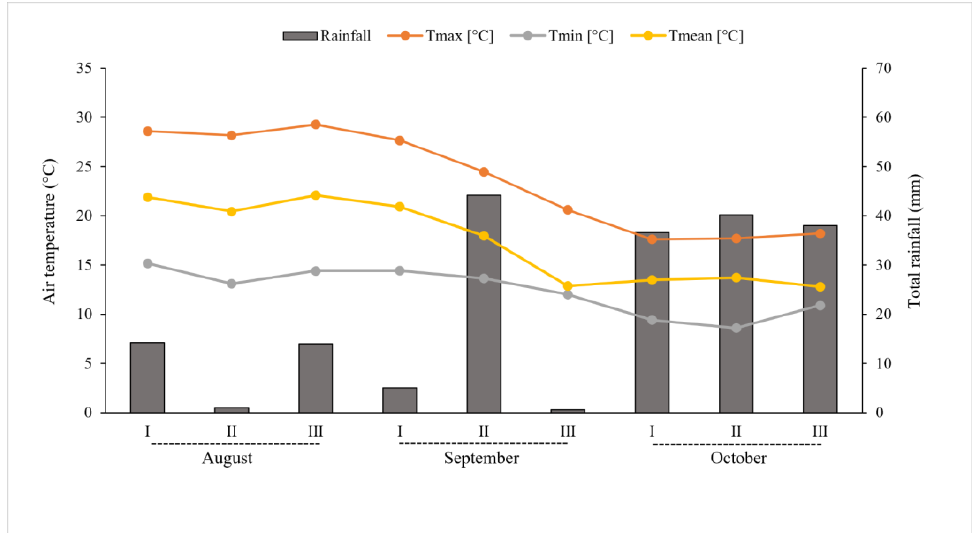
Figure 1. Cumulative (mm) precipitation and air temperatures (Tmax, Tmin, and Tmean) throughout the period between flowering and the harvesting of fruits. Data are reported for each decade (I, II, and III), from August to October 2016.